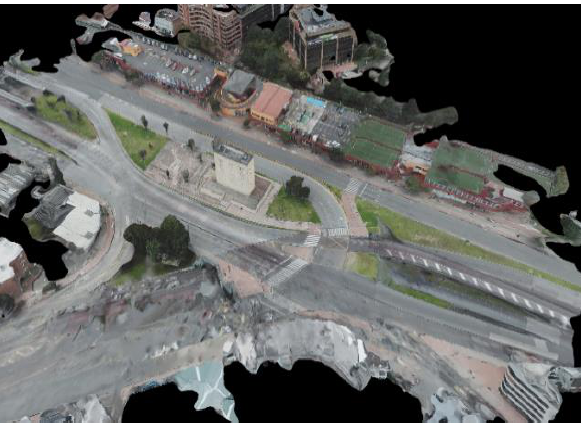
Figure 18: Overview of 3D Reconstruction of the Monument to